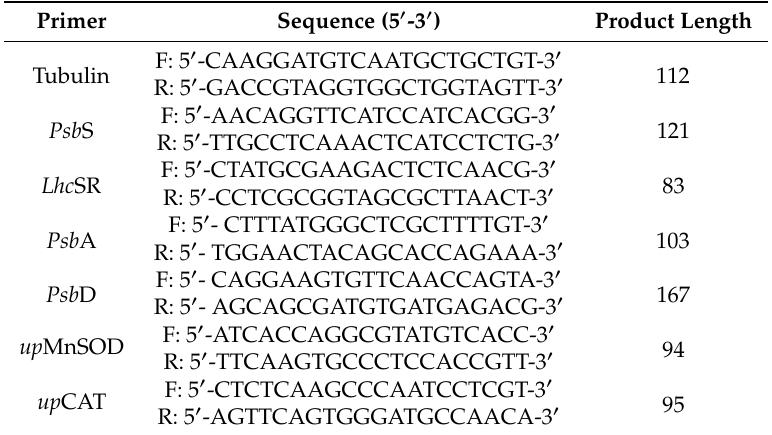
Table 2. Sequences of primer pairs in Ulva prolifera for real-time